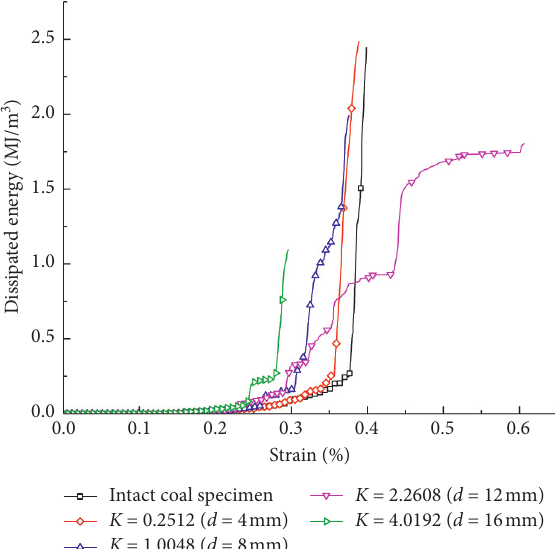
Figure 6: Curve of dissipated energy U